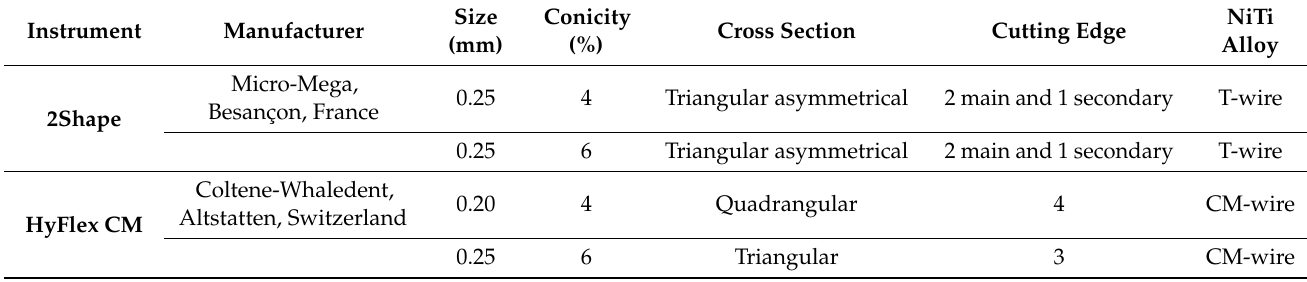
Table 1. Technical features (manufacturer, size (mm), conicity (%), cross section, cutting edge and NiTi alloy) of analyzed